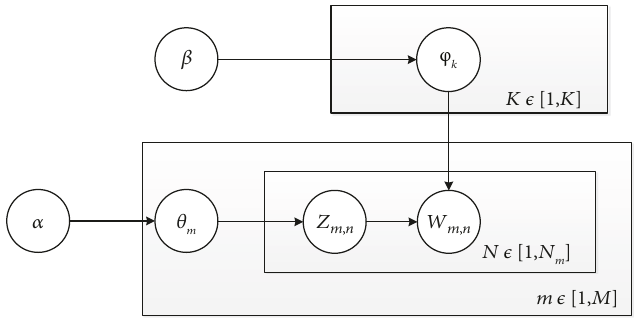
Figure 1: LDA generation process.